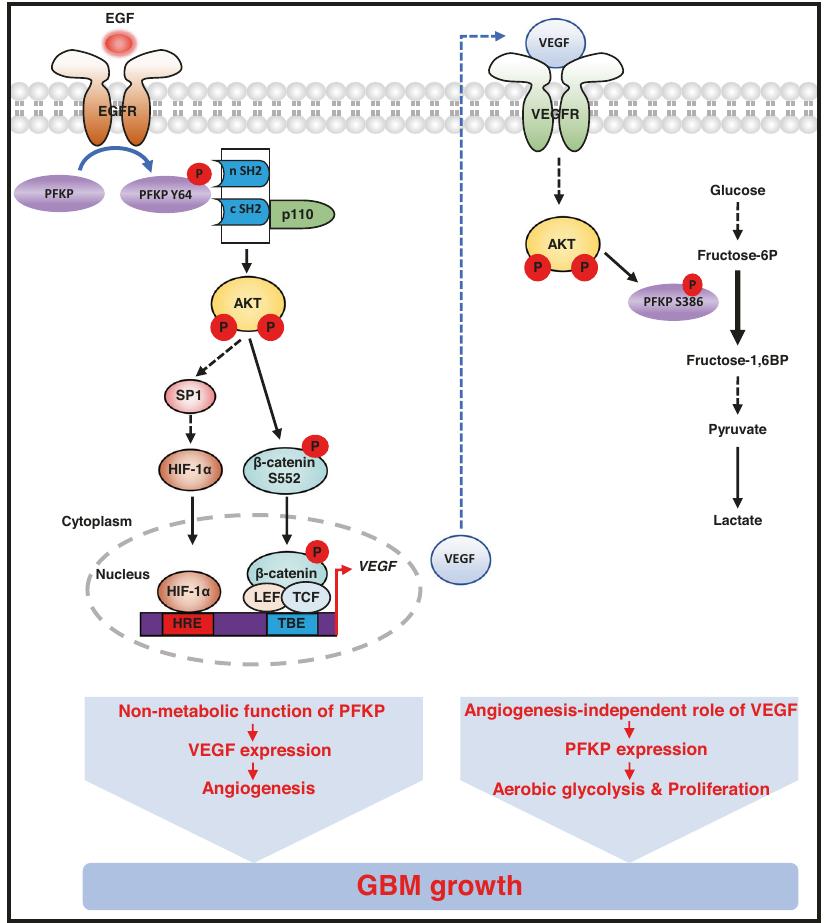
Fig. 6 Reciprocal regulation between PFKP and VEGF promotes GBM tumor growth. A schematic of the proposed reciprocal regulation that occurs between PFKP and VEGF for regulating GBM tumor growth. HRE hypoxia response element, TBE TCF binding